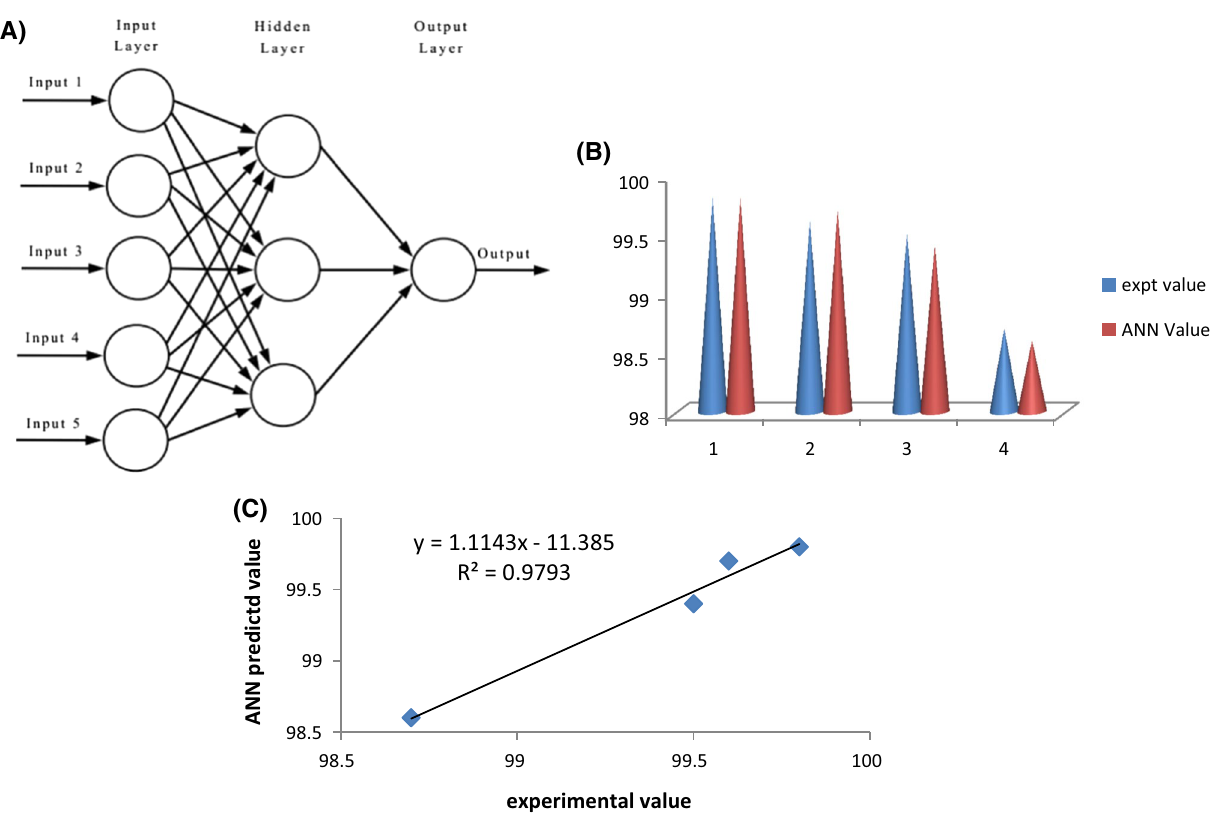
Fig. 8 a Schematic representation of ANN network trained b comparative plot for the experimental and ANN predicted values c correlation plot for the experimental and ANN predicted